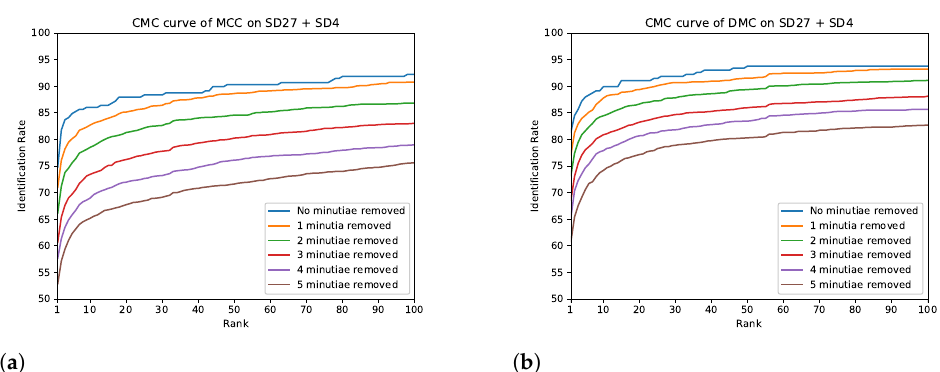
Figure 5. CMC curves for random fixed number removal of minutiae using both MCC and DMC as matching algorithms. ( a ) CMC curves for random fixed number removal of minutiae using MCC as matching algorithm. ( b ) CMC curves for random fixed number removal of minutiae using DMC as matching algorithm.